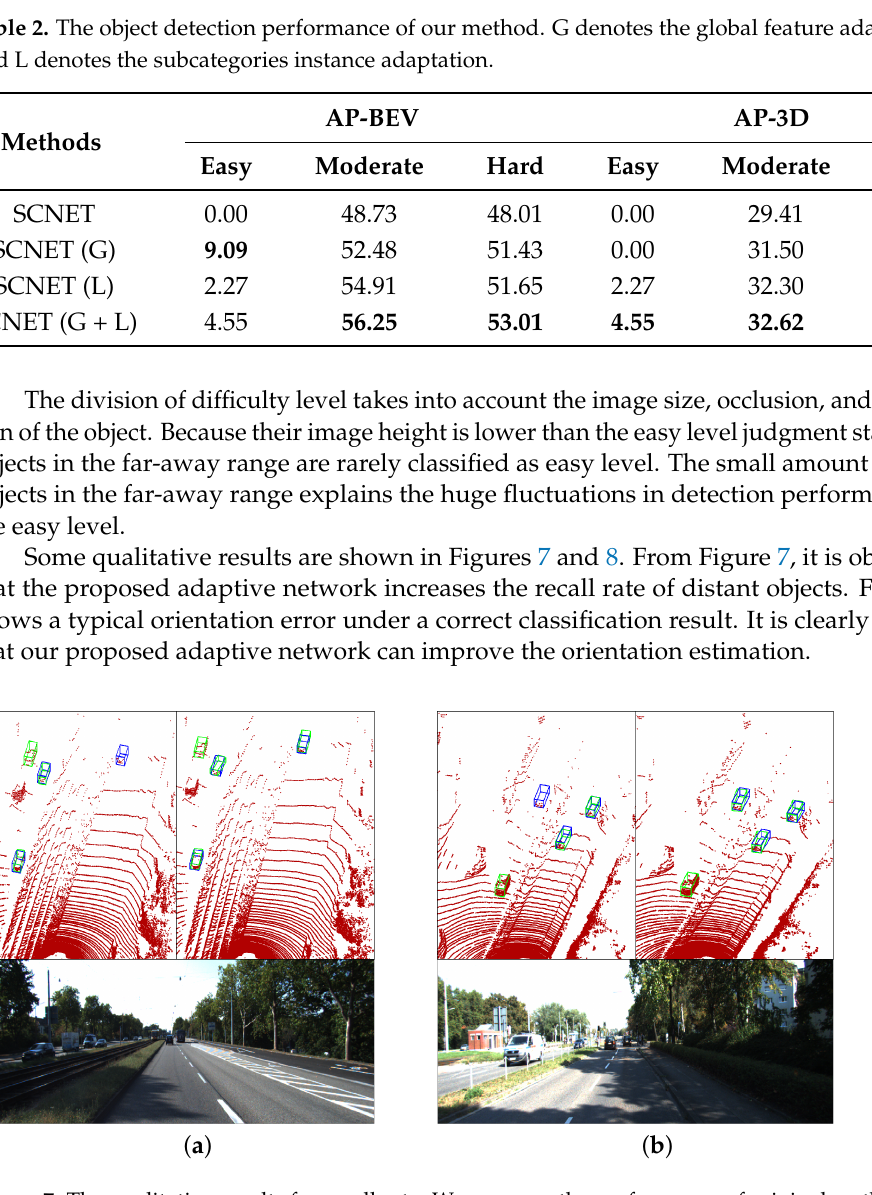
Figure 7. The qualitative results for recall rate. We compare the performance of original method and proposed adaptive method in two scenes ( a , b ). In each subfigure, the top-left picture is the original results and the top-right picture is our results. The bottom picture is the image corresponding to the point cloud. The blue bounding boxes represent the ground truth boxes, and the green bounding boxes are the detection results. The results show that the proposed adaptive network can detect some objects that cannot be detected by the original method, thereby improving the recall rate of distant